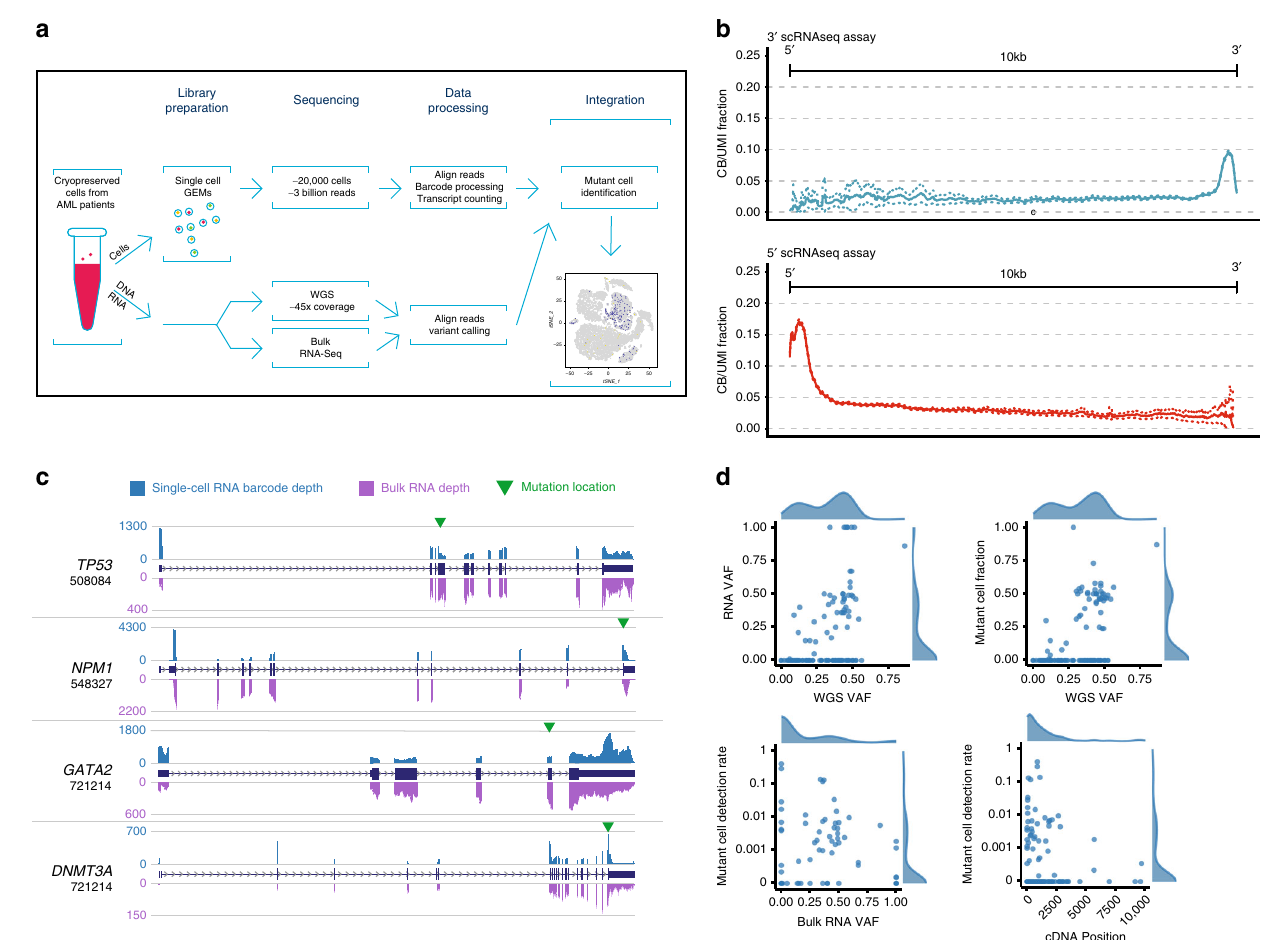
Fig. 1 Work fl ow, coverage, and performance metrics for variant detection in single cells. a Cryopreserved bone marrow cells from AML patients underwent eWGS, bulk RNA-seq, and scRNA-seq. Somatic mutations were discovered using eWGS data, identi fi ed in individual cells using scRNA-seq data, and interpreted in the context of expression heterogeneity. b Fraction of unique transcripts (molecules) whose reads map to any given position up to 10 kbp away from the capture site in both the 5 ’ and 3 ’ kits. c Comparison of single-cell and bulk RNA-seq coverage data for speci fi c genes of interest. d Relationship between RNA and eWGS VAF; dependence of Mutant Cell Fraction on eWGS VAF; dependence of Mutant Cell Detection Rate on bulk RNA VAF, and dependence of Mutant Cell Detection Rate on position of the mutation in the